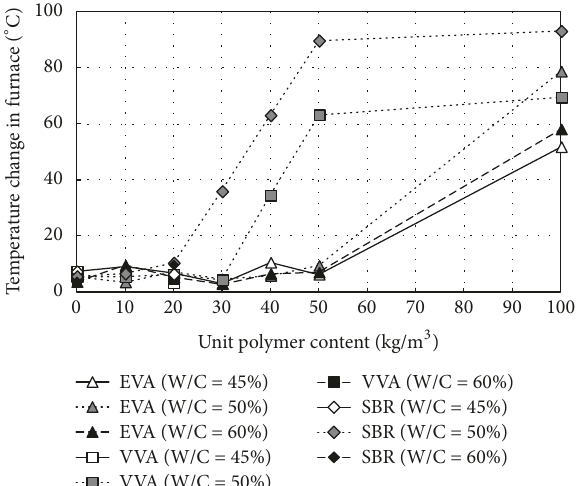
Figure 6: Relationship between unit polymer content in PCM and temperature change inside the furnace.